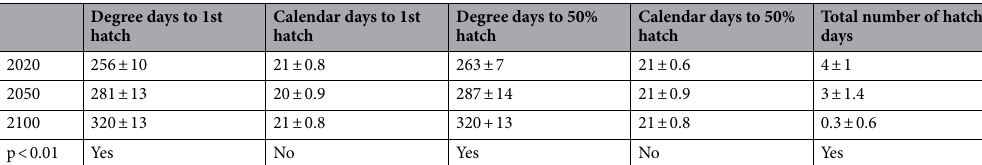
Table 1. Mean and standard deviation of degree days and calendar days to first hatch, degree and calendar days to 50% hatch, and total number of hatch days for the year 2020, year 2050, and year 2100 treatments. GLMMs with a Poisson distribution were run to determine statistical significance. Pairwise comparisons for degree days to first hatch (p 2020,2050 = 9 × 10 −7 , p 2050,2100 = 1 × 10 −6 , p 2020,2100 = 0), degree days to 50% hatch